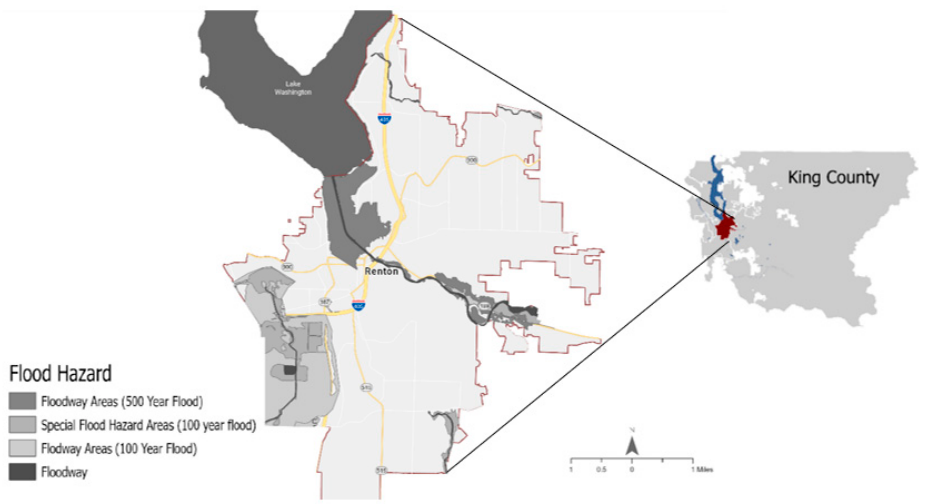
Figure 1. The location and flood hazard map of the study area (Renton city), which is located in King County, WA, USA .